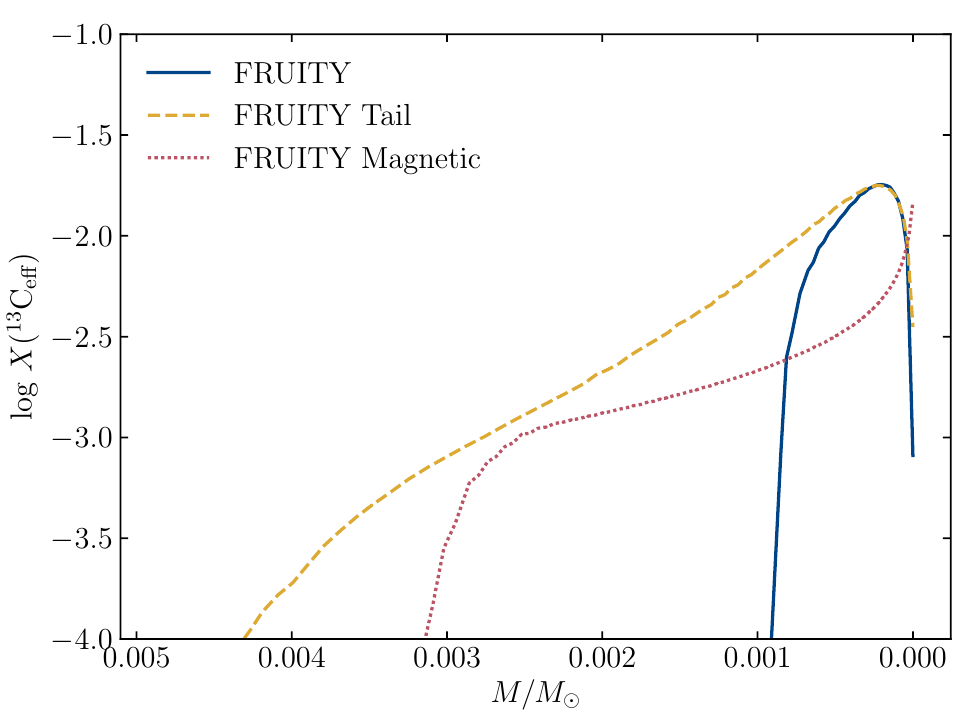
X ( 14 N ) . Since 14 N is 13/14 − ×